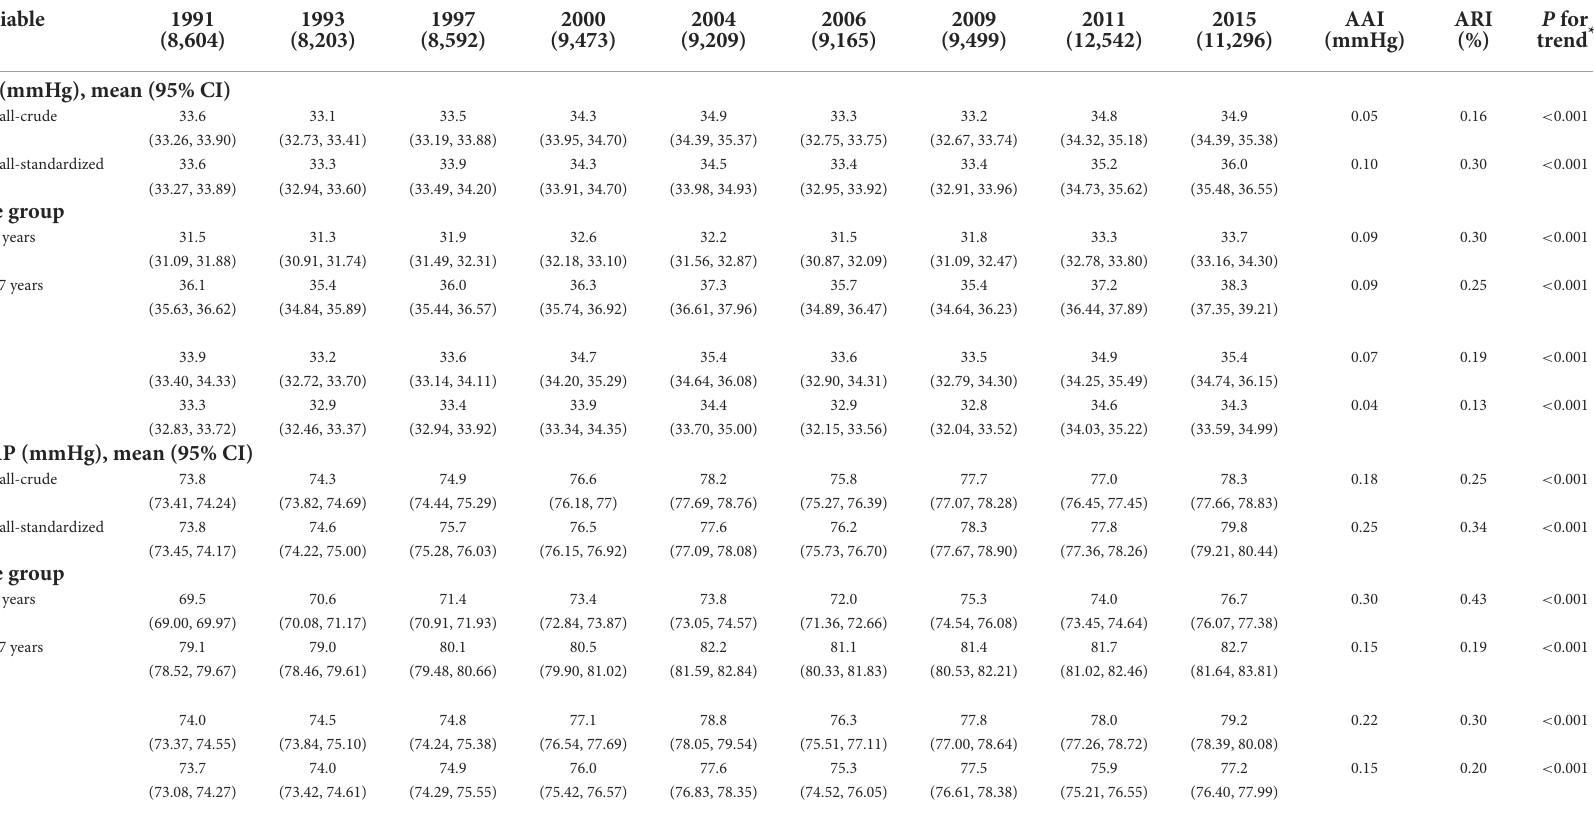
TABLE 1 Trend of PP and MAP in Chinese children and adolescents, CHNS